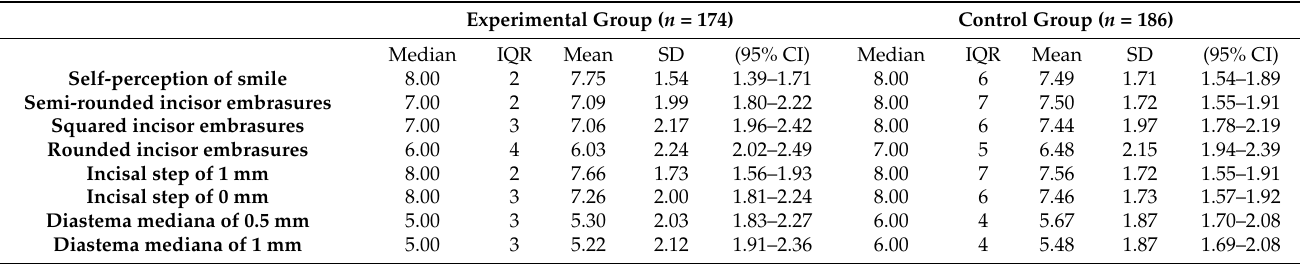
Table 4. Mean scores, standard deviations, medians, and confidence intervals for each individual anomaly in the experimental and control groups in the second testing.